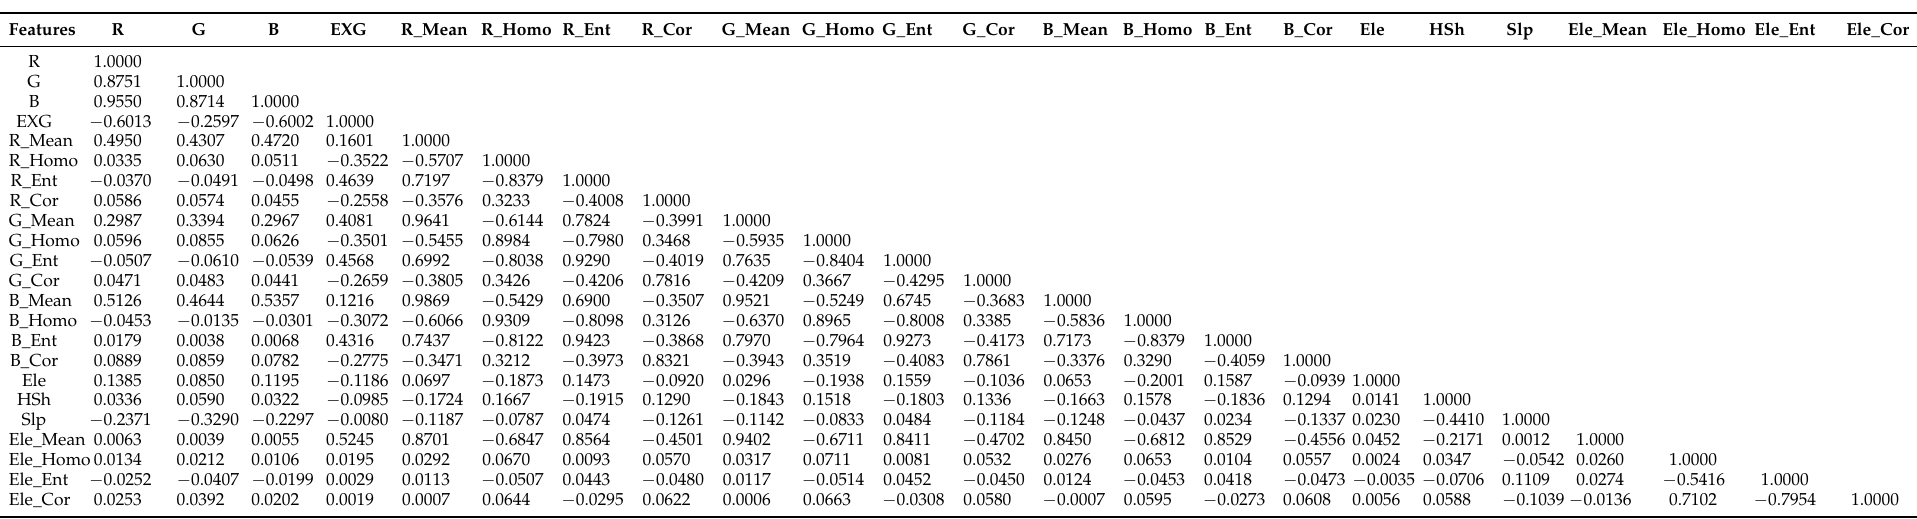
Table A1. Correlation matrix of pre-selected features for